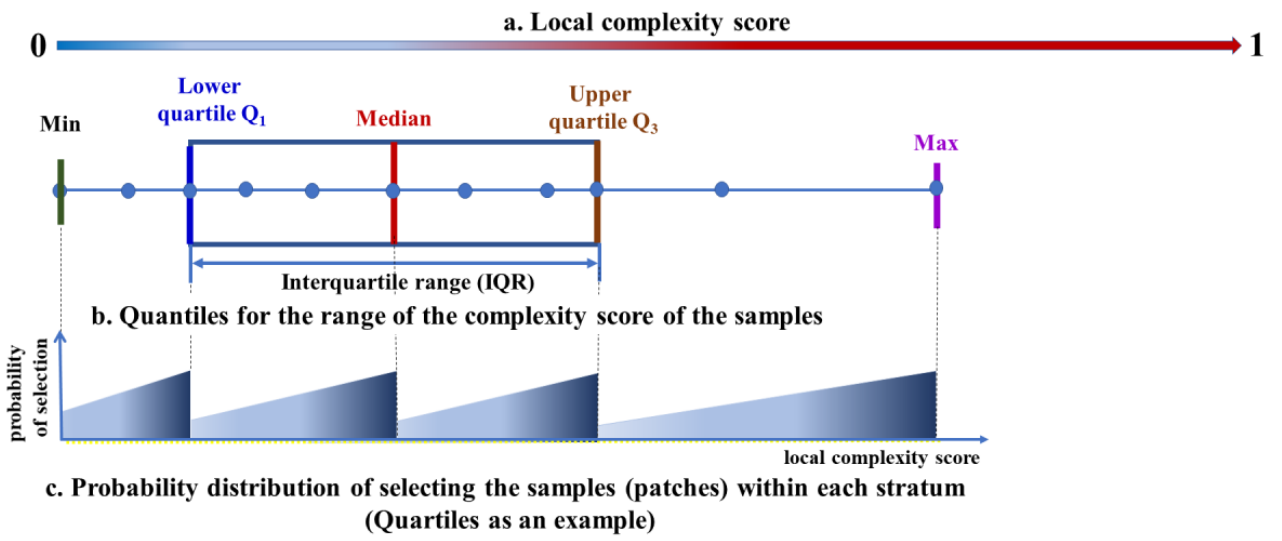
Figure 4. Optimal selection of the samples (patches) using the complexity score as the stratifying and weight